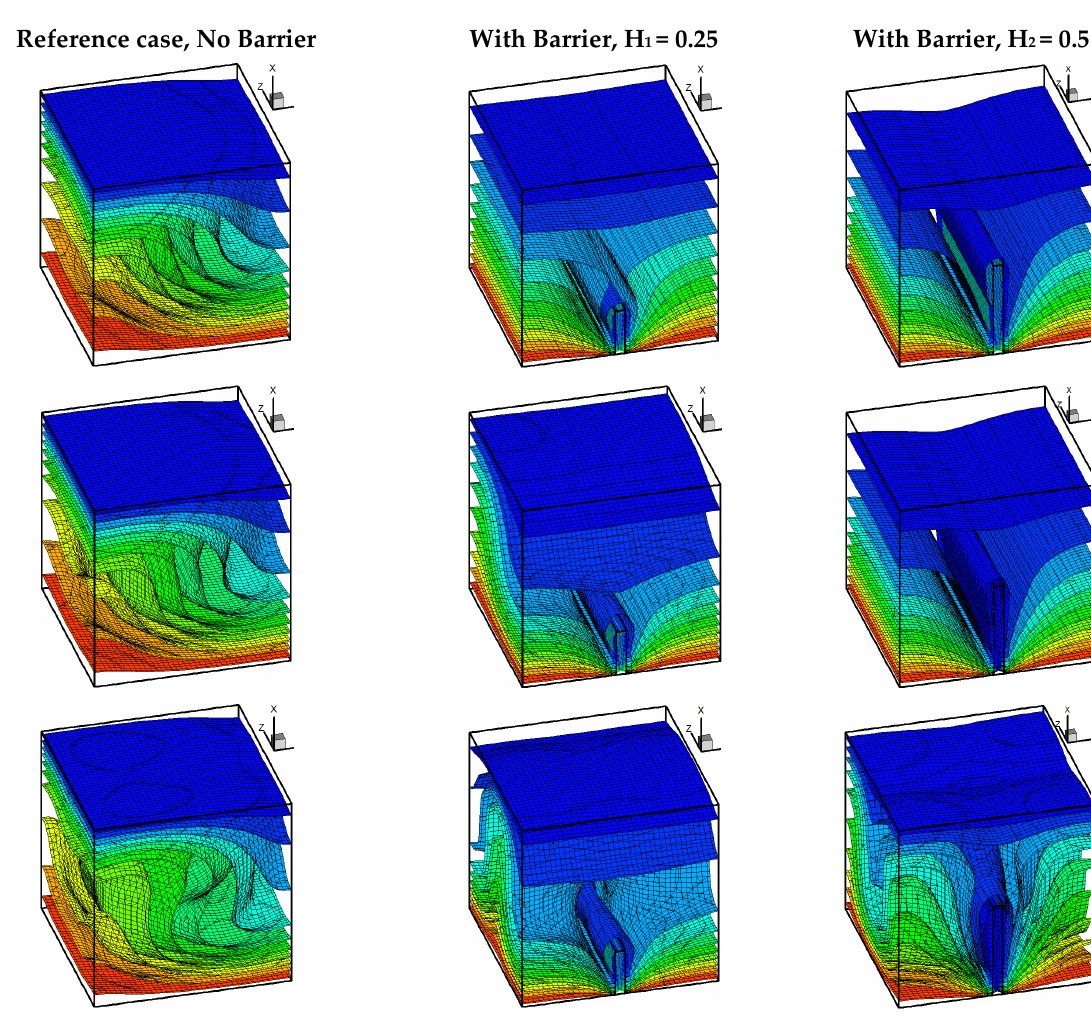
Figure 10. Temperature iso-surfaces in the building for different Ra, effect of two barriers’ heights for N = −0.2.